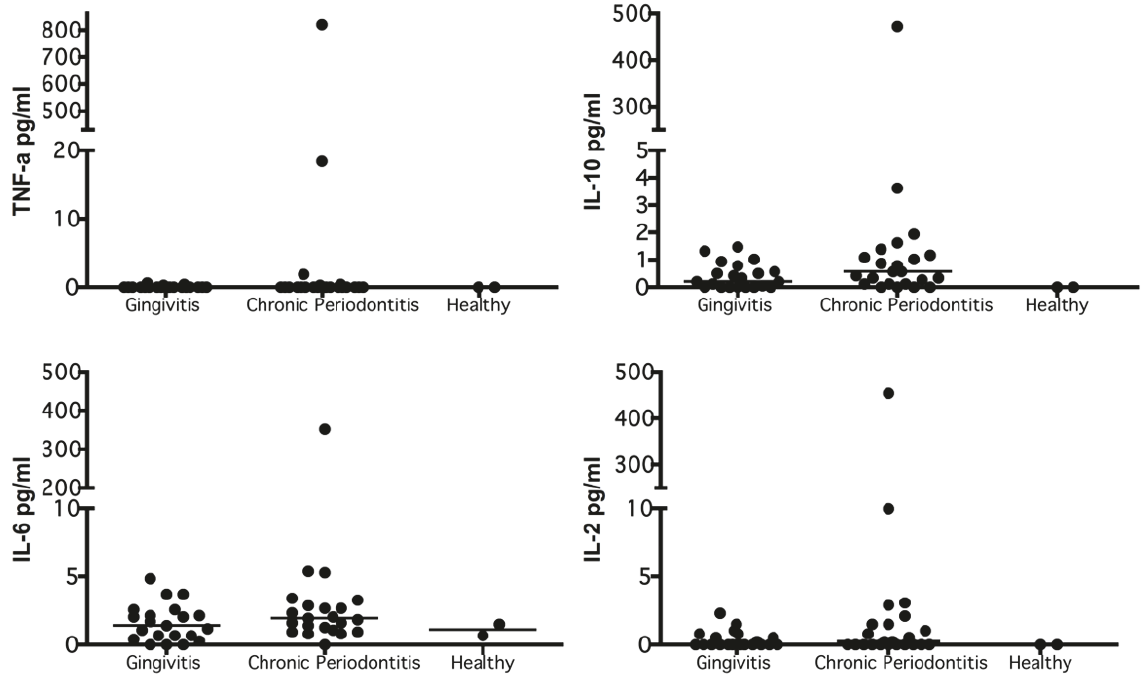
Figure 4: Quantification of cytokines by periodontal disease. Expression TNF- 𝛼 , IL-10, IL-6, and IL-2 in gingivitis (n=21), chronic periodontitis (n=23), and healthy (n=2). Systemic cytokines were quantified using the CBA and by Flow Cytometer 50,000 events were acquired and analyzed using FCAP Array software. The concentrations obtained were expressed in pg/ml and compared between groups by a bivariate analysis. The data are represented by the median for each